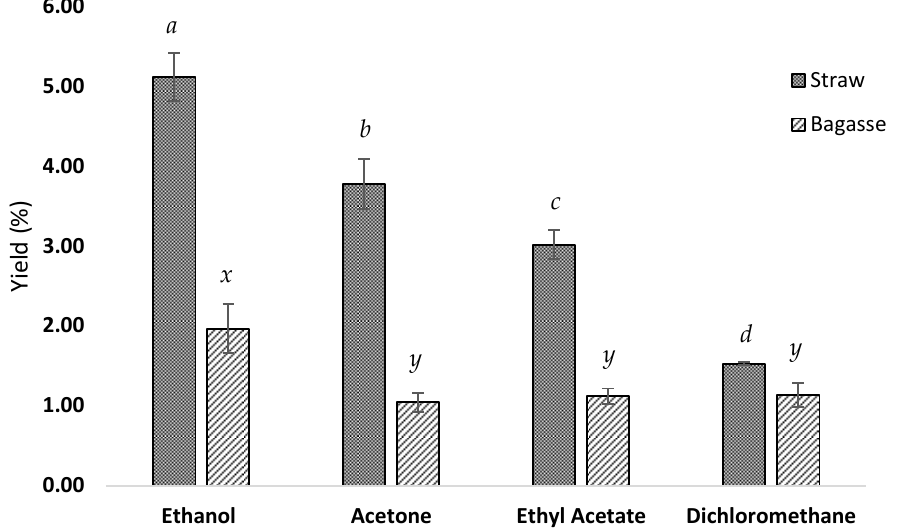
Figure 2. Lipophilic extraction yields (%) of straw and bagasse samples with different solvents. Different letters indicate statistically significant differences between solvents ( p < 0.05). a, b, c and d for straw samples and x and y for bagasse samples.